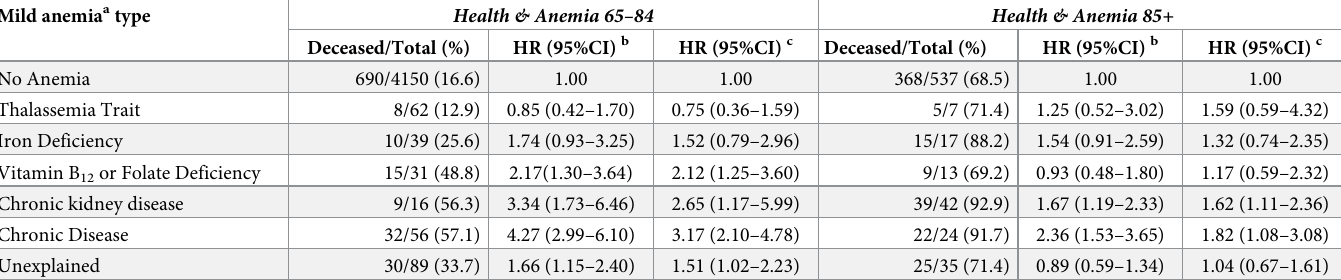
Table 3. Risk of mortality associated with mild anemia type over seven years in participants aged 65–84 and 85 or older years at blood sample from the Health and Anemia population-based